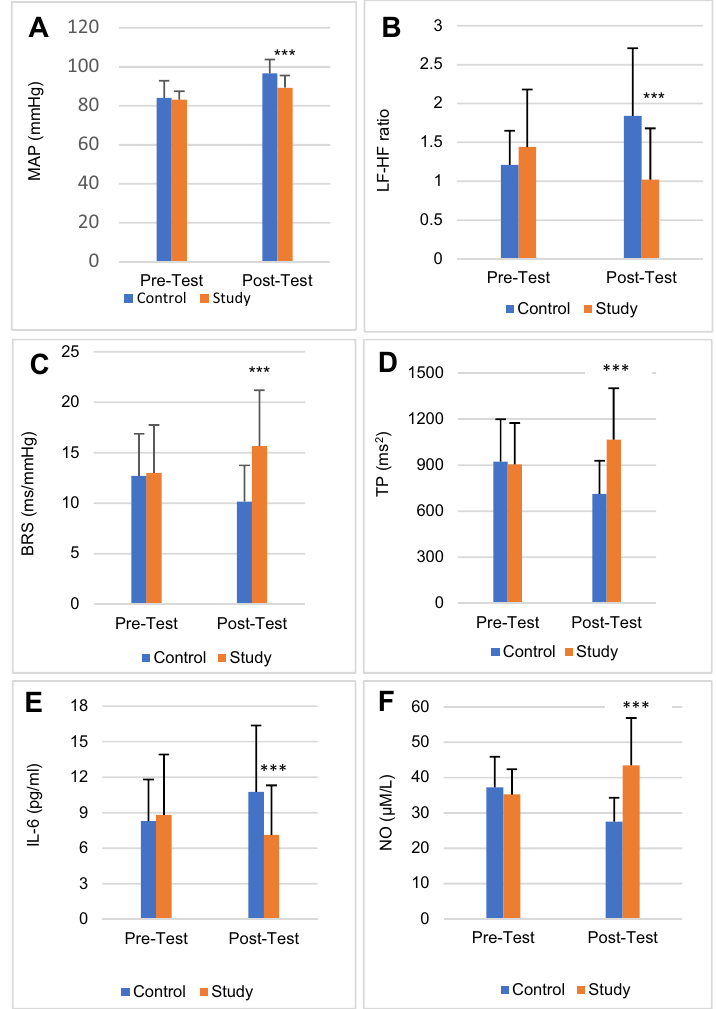
Figure 16. Comparison of MAP (A) , LF-HF ratio (B) , BRS (C) , TP (D) , IL-6 (E) and NO (F) in control and study groups before and after intervention. Results are shown as Mean ± SD. There was no significant difference in any of the parameters between control and study groups before yoga intervention (Pre-Test). Following intervention (Post-Test), MAP, LF-HF ratio and IL-6 were significantly decreased and BRS, TP and NO were significantly increased in the study group compared to the control group. *** p <